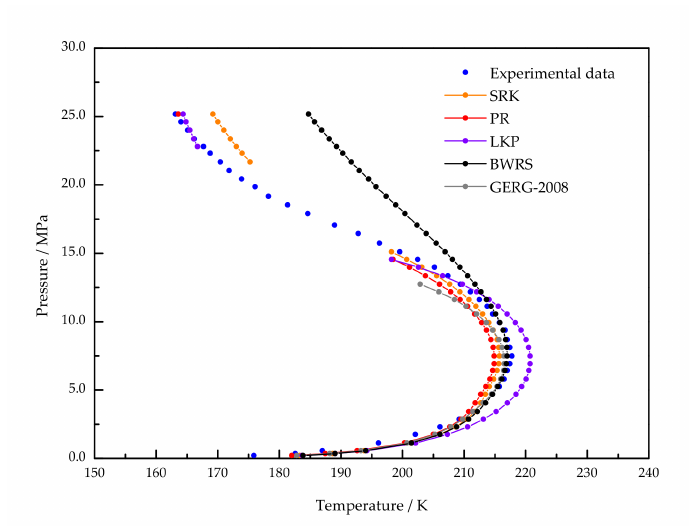
Figure 5. Experimental and calculation results of dew points for Sample 4.